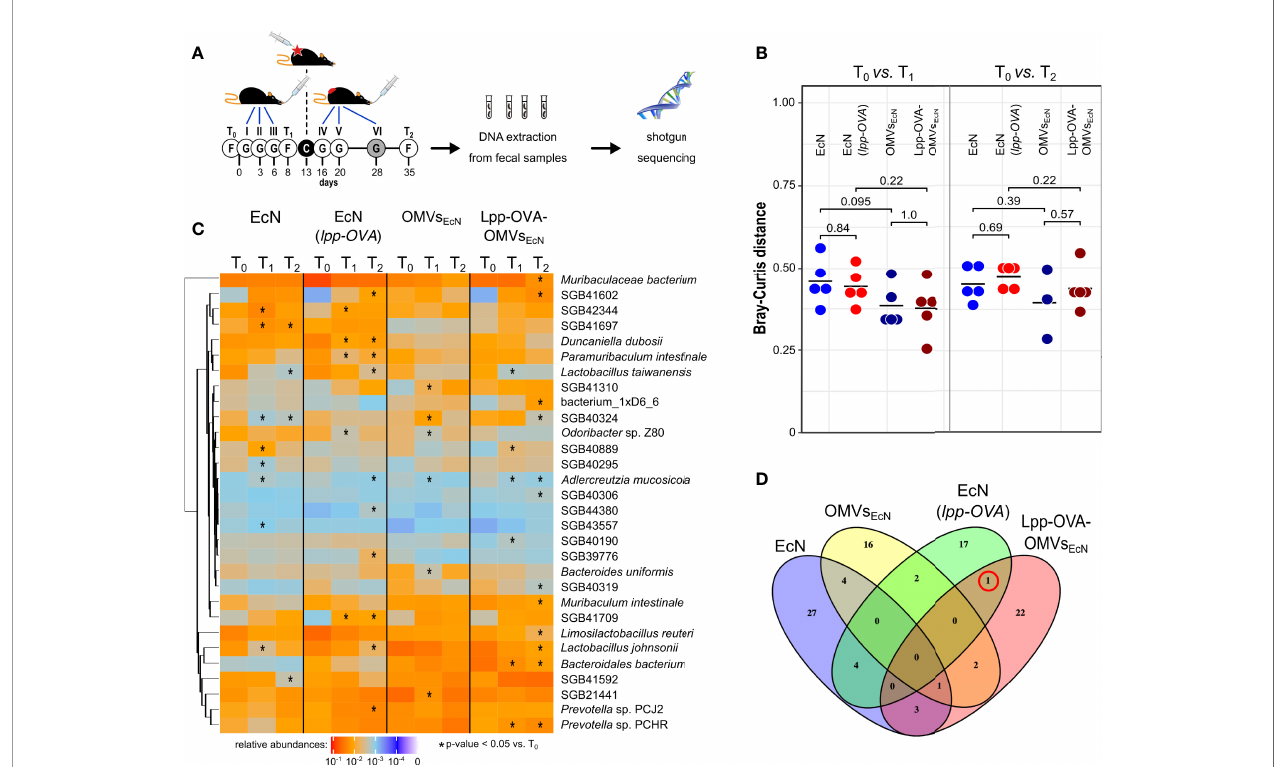
FIGURE 5 | Effect of EcN, EcN( lpp-OVA ), OMVs EcN and Lpp-OVA-OMVs EcN oral administration on gut microbiome composition. (A) Schematic representation of the experimental procedure. Mice were given three gavages (G) with either EcN, EcN( lpp-OVA ), OMVs EcN or Lpp-OVA-OMVs EcN . Mice were challenged with OVA- B16F10 cells (C) and then they received two (in the case of OMVs) or three additional oral administrations. Fecal samples were collected before the fi rst gavage (T 0 ), before the tumor challenge (T 1 ) and at the end of the experiment (T 2 ) and fecal DNA was subjected to shotgut sequencing. (B) Microbiome diversity in all mice within each treatment group at different time points (T 0 vs . T 1 and T 0 vs . T 2 ) estimated as Bray-Curtis distance. Statistical differences between group pairs were calculated through Wilcoxon Rank Sum Test. (C) Heatmap representing the relative abundance of the top 30 most abundant bacterial species that showed statistical variation within each group at different time points (T 0 vs . T 1 and T 0 vs . T 2 ) (*P ≤ 0.05). (D) Venn diagram showing the overlap of species with signi fi cant variations in relative abundance between T 0 vs . T 1 (Wilcoxon Rank Sum Test P ≤ 0.05). The red circle highlights SGB43006, which increases at T 1 compared to T 0 in mice treated with EcN( lpp-OVA ) and Lpp-OVA-OMVs EcN